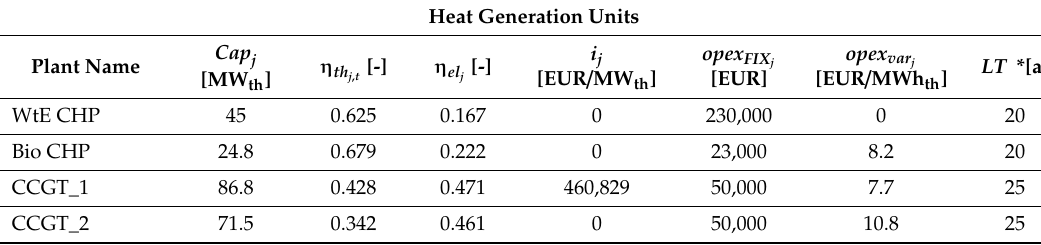
Table A5. Detailed model parameter of heat generation and heat storage units of the status quo and the future portfolio